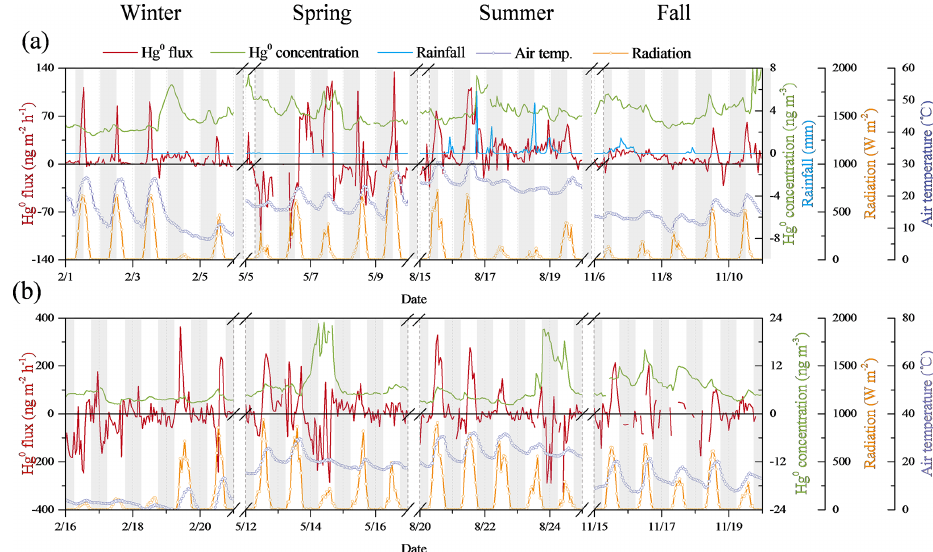
Figure 7. The GEM flux, concentration and environmental conditions on some typical days in each season at sites (a) QYZ and (b) HT. Dates refer to China Standard Time (major ticks indicate midnight). All the data are indicated as 1h average.